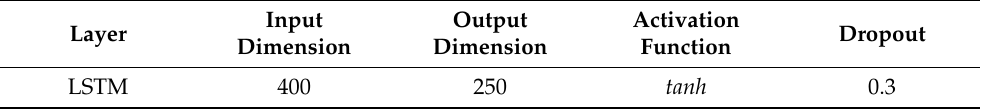
Table 4. LSTM Layered Architecture